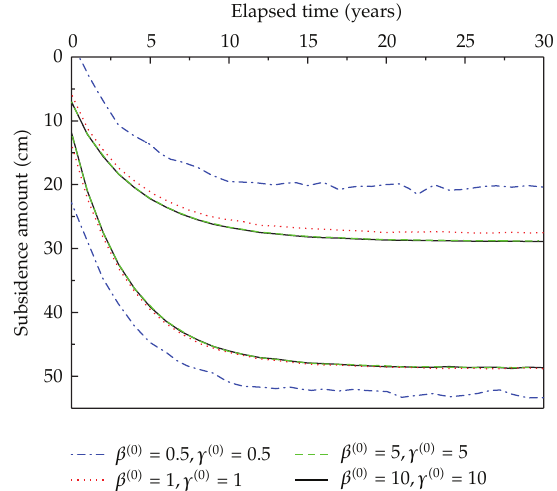
Figure 5: 95% credible interval of predicted subsidence